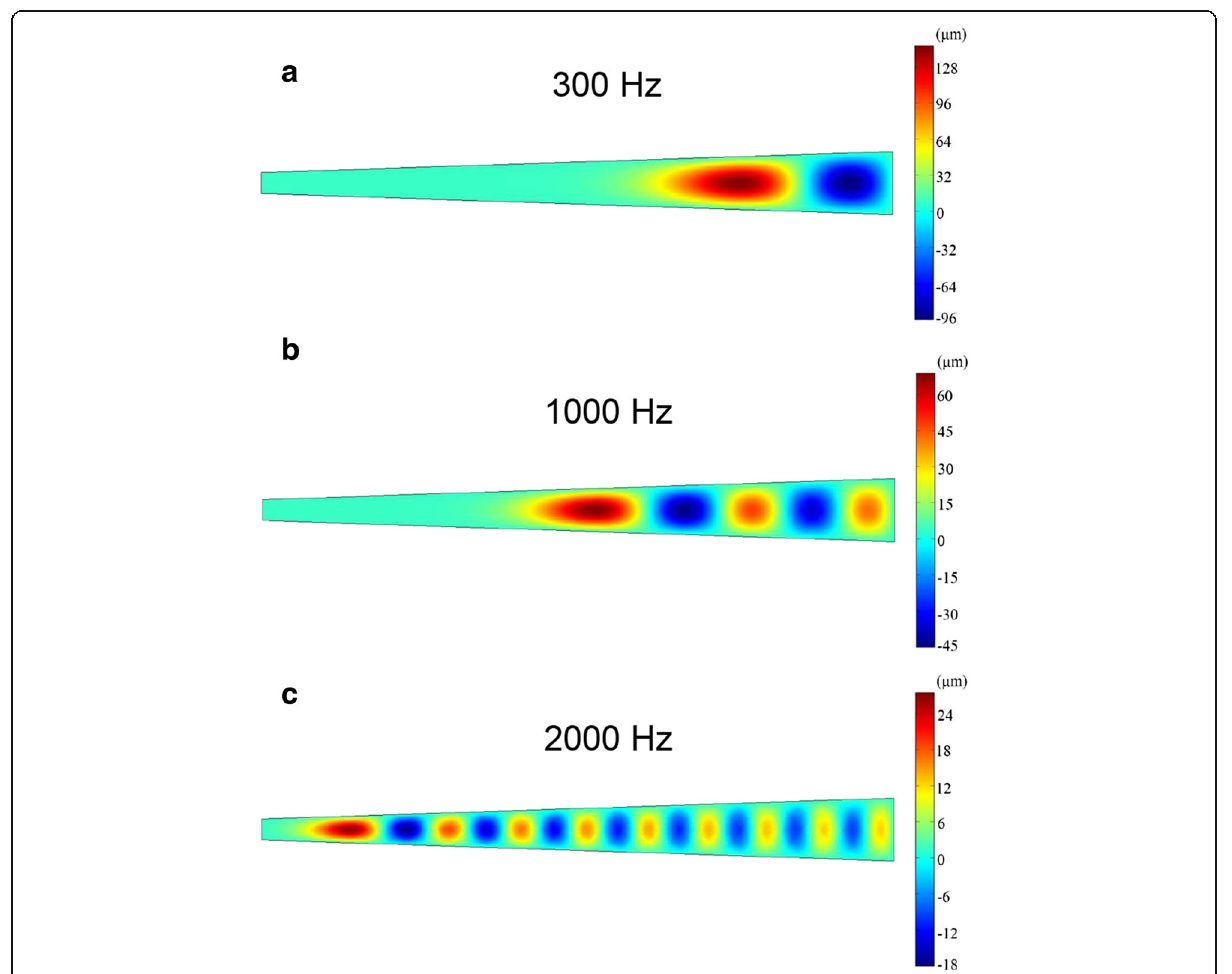
Fig. 5 The Comsol software was employed to stimulate the vibration characteristics of single PTFE membrane at the frequency of a 300 Hz, b 1000 Hz, c 2000